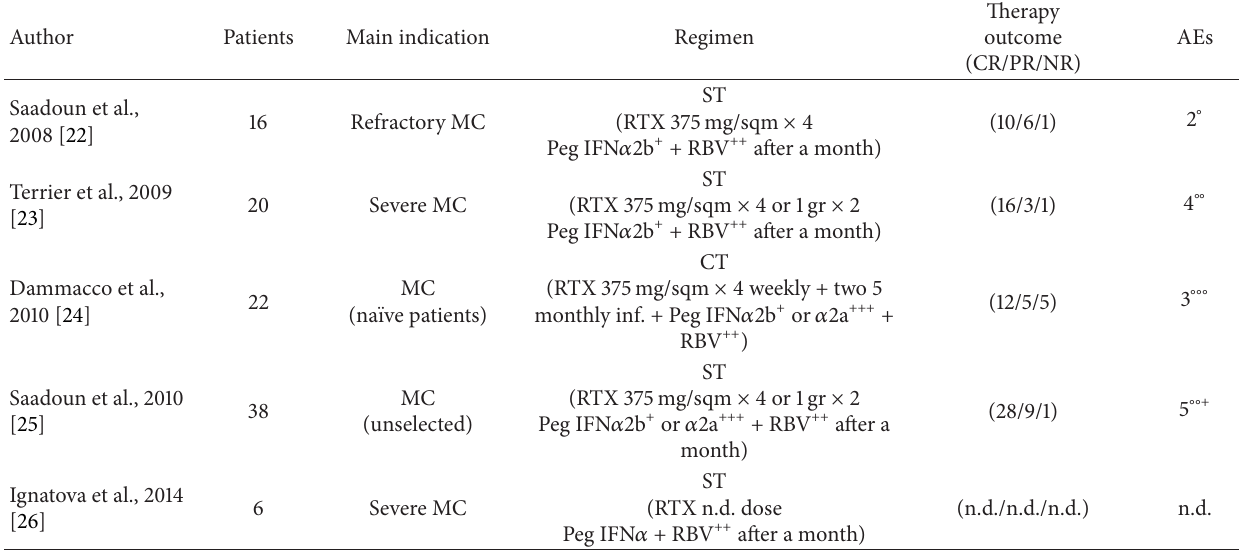
Table 2: Combined treatment with antiviral therapy and rituximab in MC patients: review of the